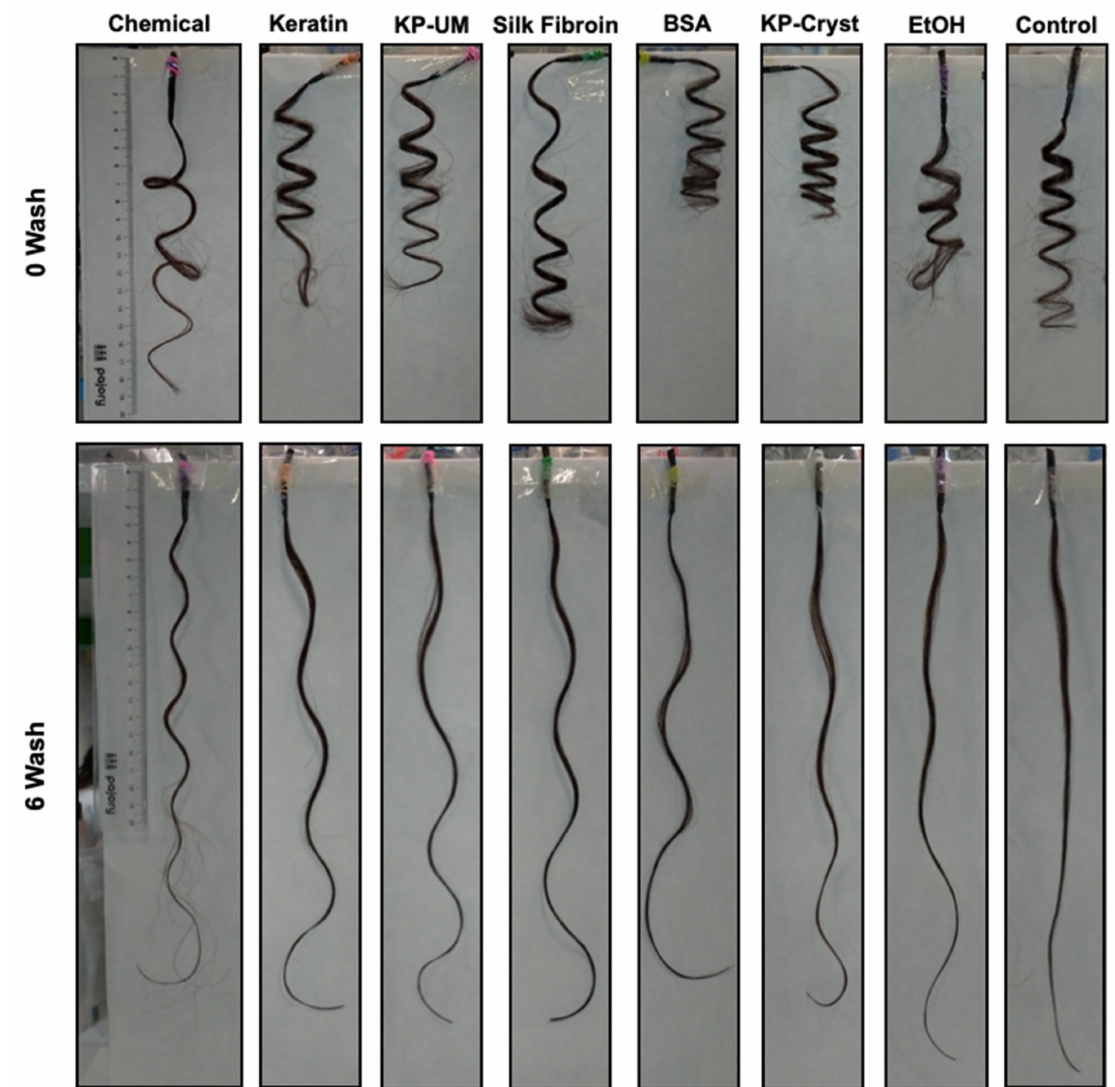
Figure 2. Effect of hair washing with a commercial shampoo on the curliness of Asian hair. The hair tresses were treated with keratin, KP-UM, silk fibroin, bovine serum albumin (BSA) and KP-Cryst proteins dissolved in phosphate buffer (pH7) before curling using a hot BaByliss. Hair treated with a commercial formulation for perming (“Chemical”), treated with the ethanolic formulation and phosphate buffers (“EtOH”), or without any treatment (“Control”) were used as controls for the proteins’ capacity to curl the Asian